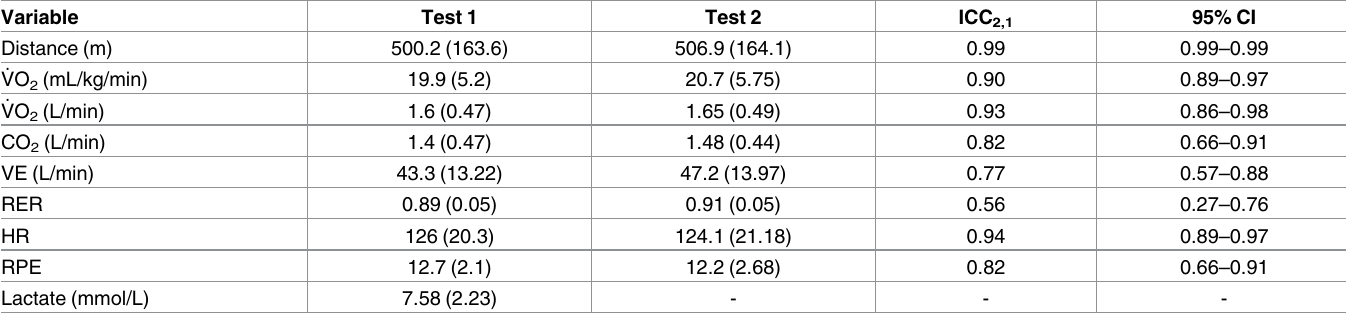
Table 2. Reliability measuresfor the 6MWT (n = 31).